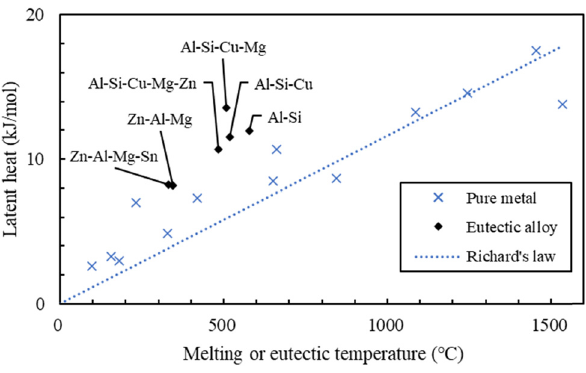
Figure 6: Richard ’ s law and eutectic alloys.